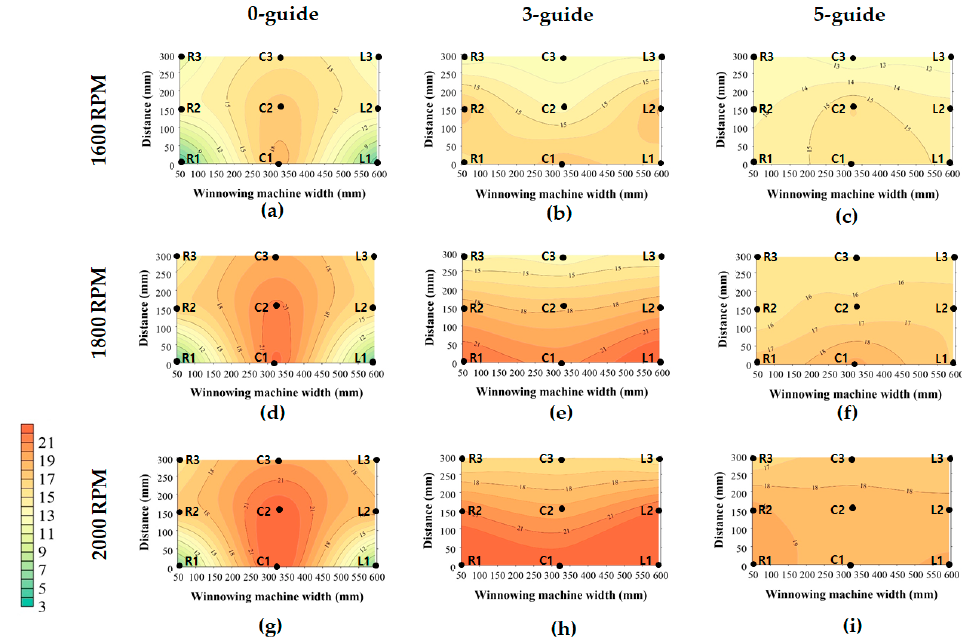
Figure 11. Results of CFD analysis for wind velocity on conditions of 0-guide ( a ), 3-guide ( b ), 5-guide ( c ) at 1600 RPM, and 0-guide ( d ), 3-guide ( e ), 5-guide ( f ), at 800 RPM, and 0-guide ( g ), 3-guide ( h ), 5-guide ( i ) at 2000 RPM. Table 6. Experimental results of wind speed by the shape of the winnowing machine and measure- ment